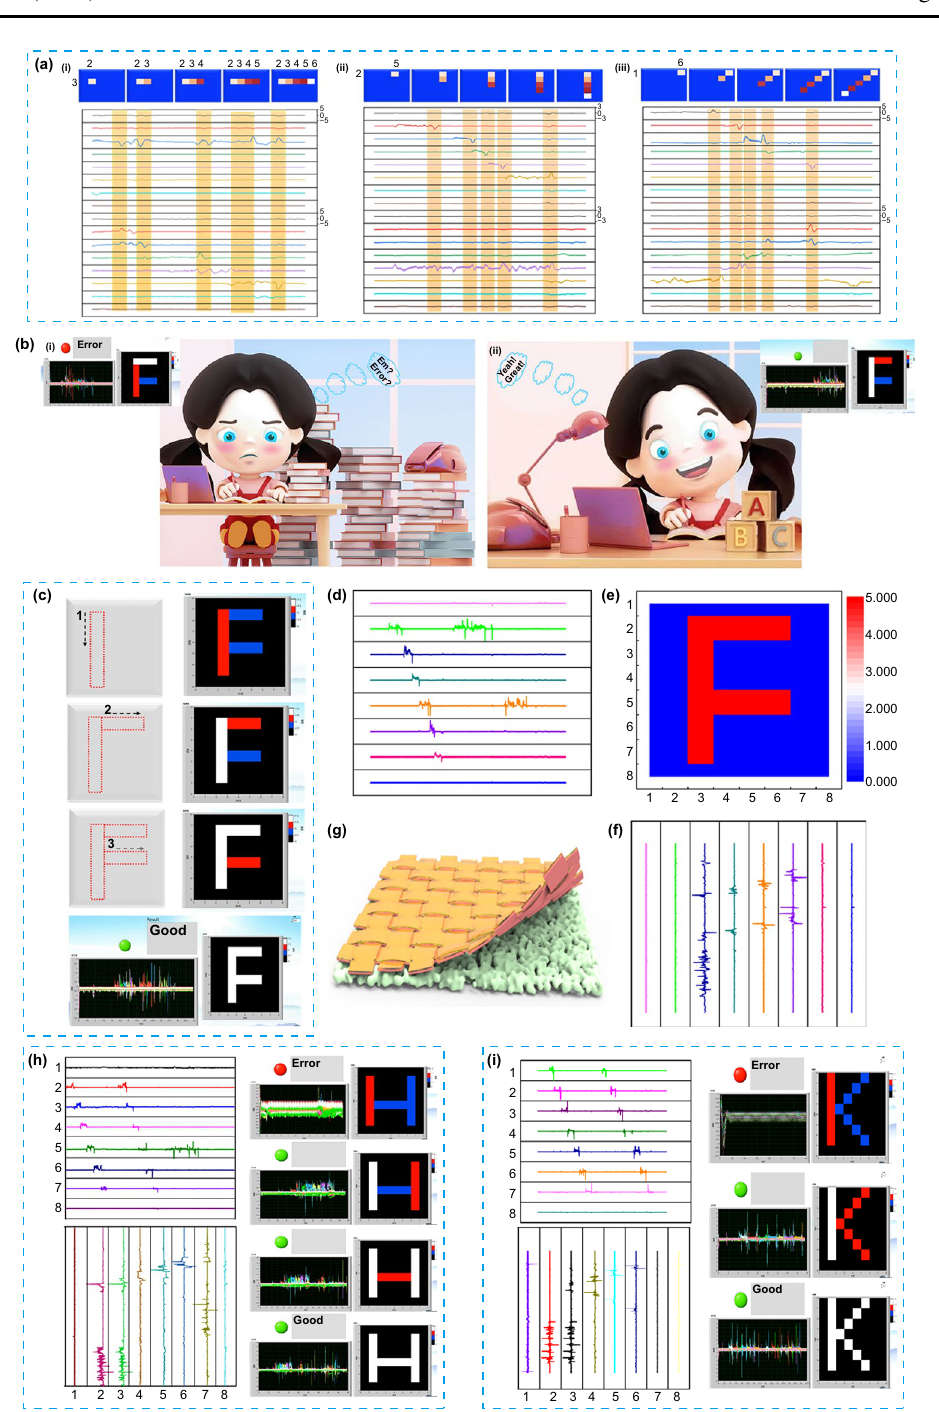
Fig. 4 The illustration of details recorded by using CSF-TENG. a ( i ) Electrical signals of stroke “ − ” inset: the detailed steps and the output of stroke “ − ” on writing pad. ( ii ) Electrical signals of stroke “|” inset: the detailed steps and the output of stroke “|” on writing pad. (a-iii) Electri- cal signals of stroke “/” inset: the detailed steps and the output of stroke “/” on writing pad. “1,2,3,4,5,6” represent electrodes. b The illustration of the writing results of letter F over different step. c The standard of writing steps of letter F and the schematic illustration of letter F recognition and identification process by CSF-TENG-based HMI. d–f Signals for writing the letter “F”. g Structure and fabrication of the CSF-TENG. h–i Signals for writing the letter “H”and “K, the schematic illustration of letter “H”and “K recognition and identification process by CSF-TENG- based